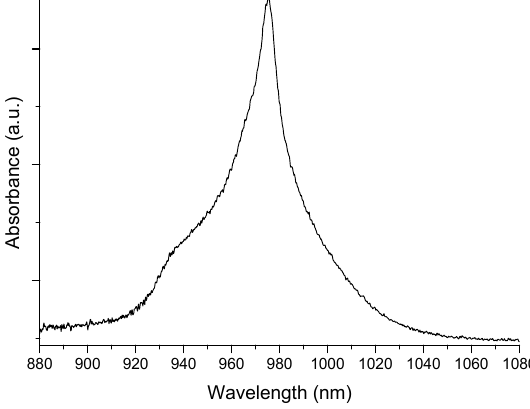
Figure 4. Near infrared absorption spectrum of 79 SiO 2 -16 AlO 1.5 -5 YbO 1.5 bulk gel.